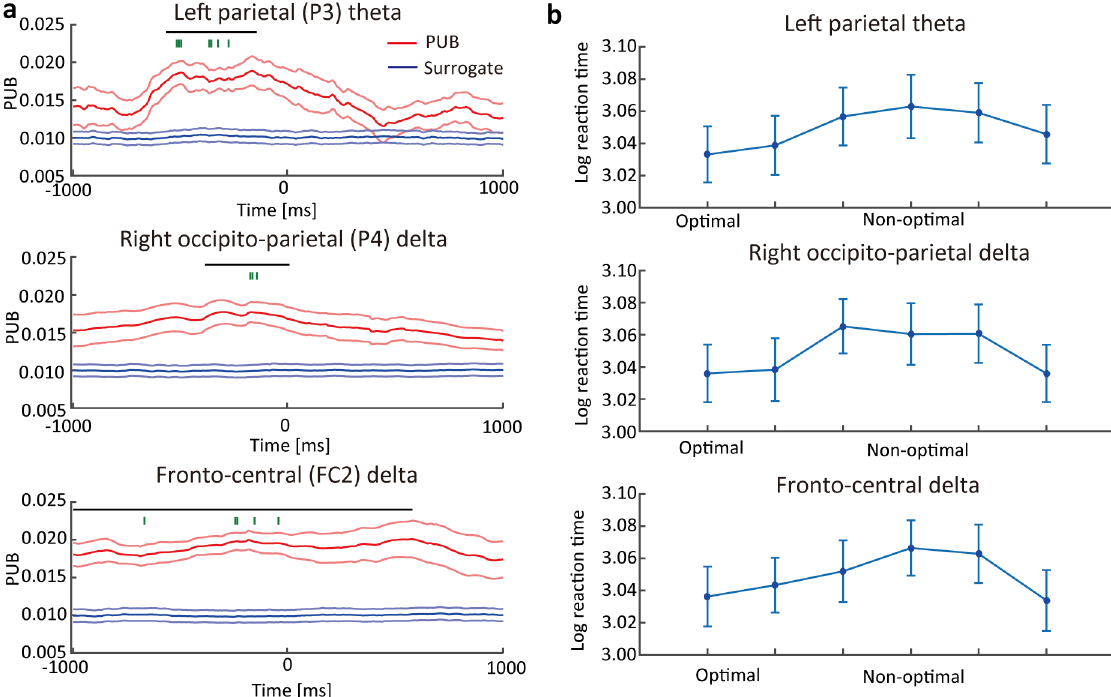
Fig 4. The effect of the phase on reaction time. (a) The PUB (red line with ± s.e.m.) and surrogate value (blue line ± s.e.m.) were averagedamongthe participants for the P3 (top), P4 (middle), and FC2 (bottom) electrodes. The black horizontalbars on each panel represent the period when a significantdifference occurred (cluster level p < 0.05). Green vertical bars indicatethe time point for the ANOVA analysisselectedby the leave-one-participant-out cross-validationstatistics. (b) Logarithmic reaction time as a function of phasebins derived from the PUB analysis. The trials were classifiedinto six groups based on the optimal phase estimated by the PUB analysis. The blue plots and vertical bars represent the averagelog-reactiontimes and their s.e.m.